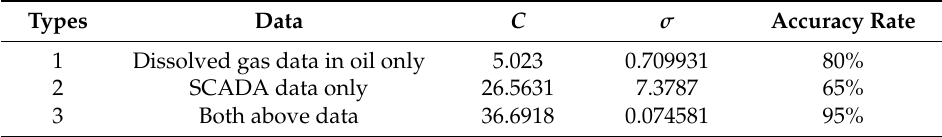
Table 3. Fault-diagnostic results of transformer of different